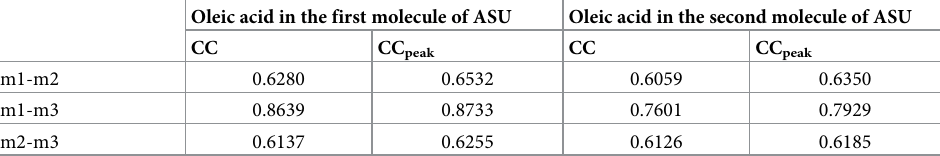
Table 2. Local correlation coefficients (CC) and CC peak values for the three polder (OMIT) maps: m1, m2 and